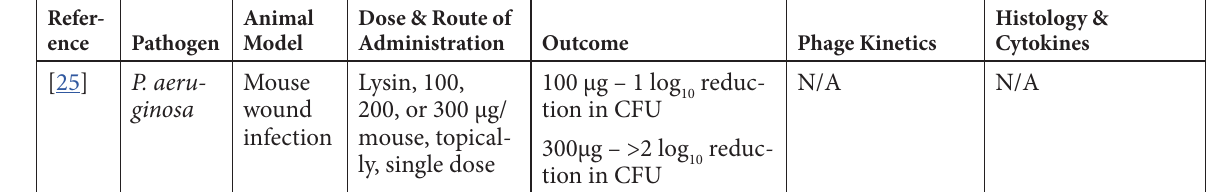
Table 3. Animal Wound Infection